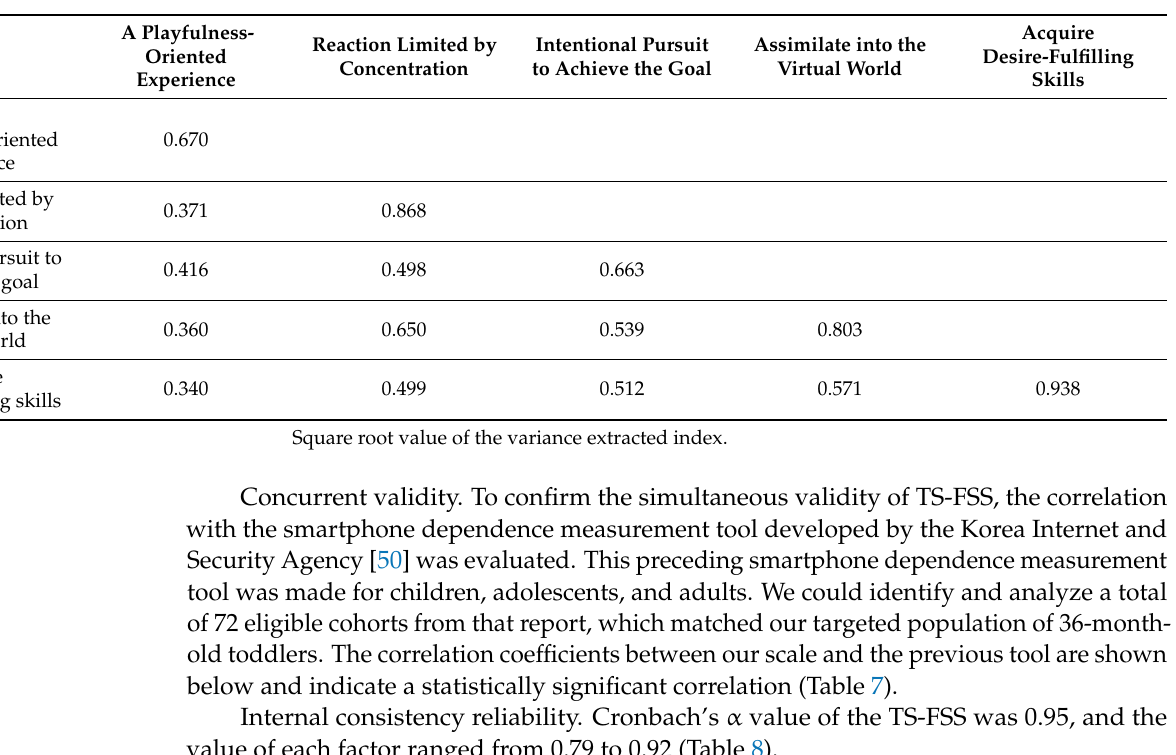
Table 6. Discriminant validity for TS-FSS ( n =